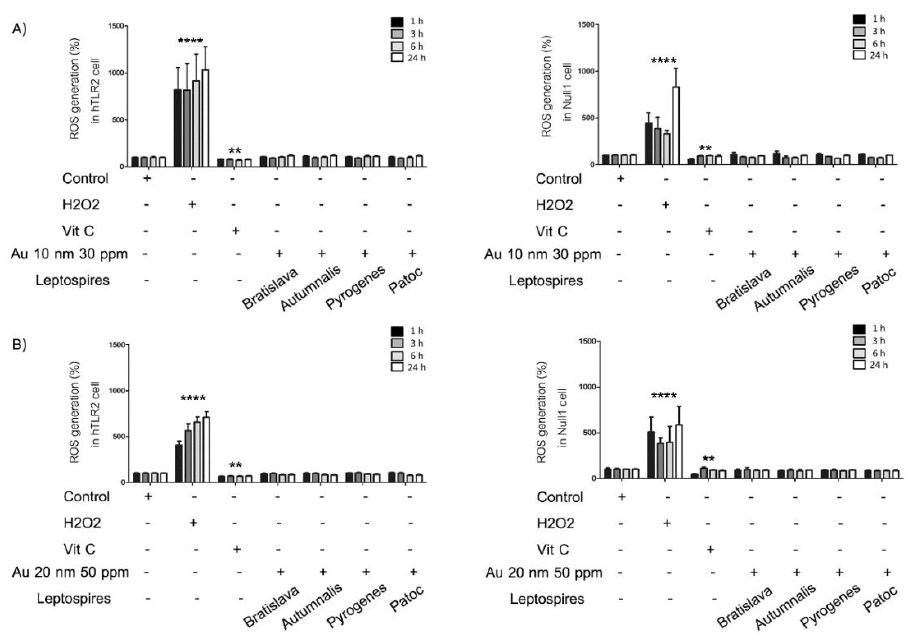
Figure 5. Effect of ( A ) 10 nm and ( B ) 20 nm AuNPs in combination with a different Leptospira serovar on the relative level (%) of reactive oxygen species (ROS) generation by (left) HEK-Blue-hTLR2 and (right) HEK-Blue-Null1 cells after 1, 3, 6 and 24 h. The level of ROS was detected using the DCFH-DA assay and expressing the fluorescence intensity relative to that for the control group. Data are shown as the mean ± SD (n = 6). Significance of the difference compared to the control group is shown as ** and **** for p < 0.01 and p < 0.0001, respectively.